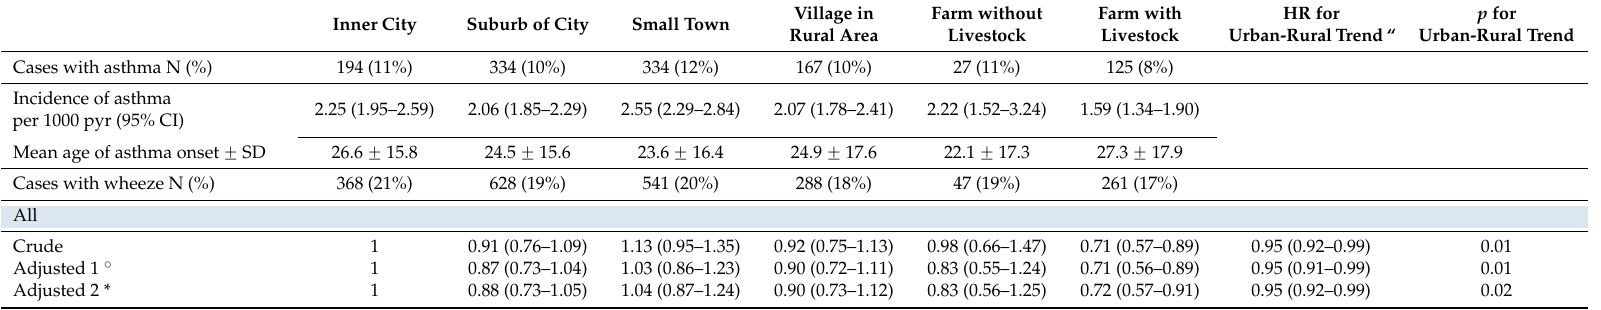
Table 2. Descriptive data on asthma and wheeze and Cox regression analyses on asthma for all presented as HR (95% CI). Inner City Suburb of City